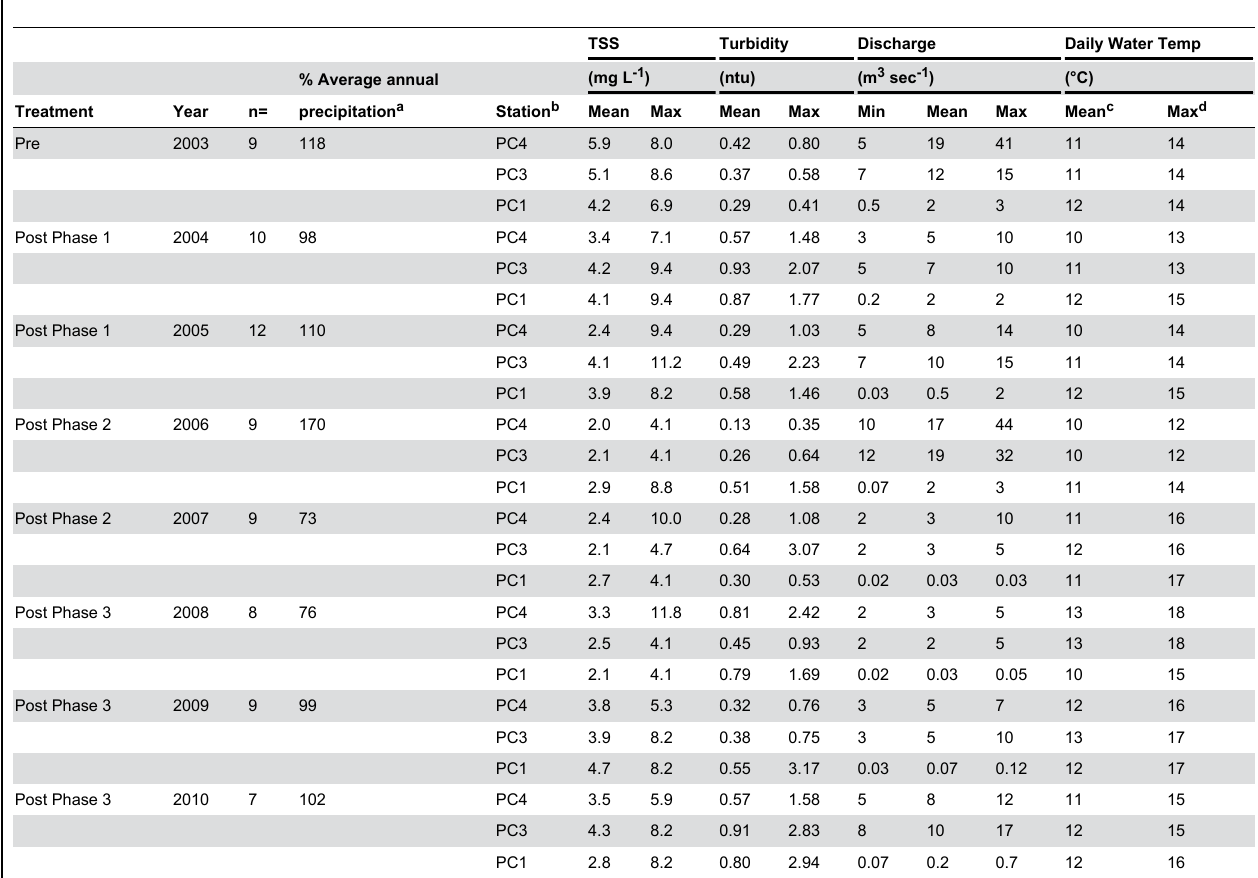
Table 2. Mean and maximum annual values of total suspended solids (TSS), turbidity, discharge and stream temperature measured at Pine